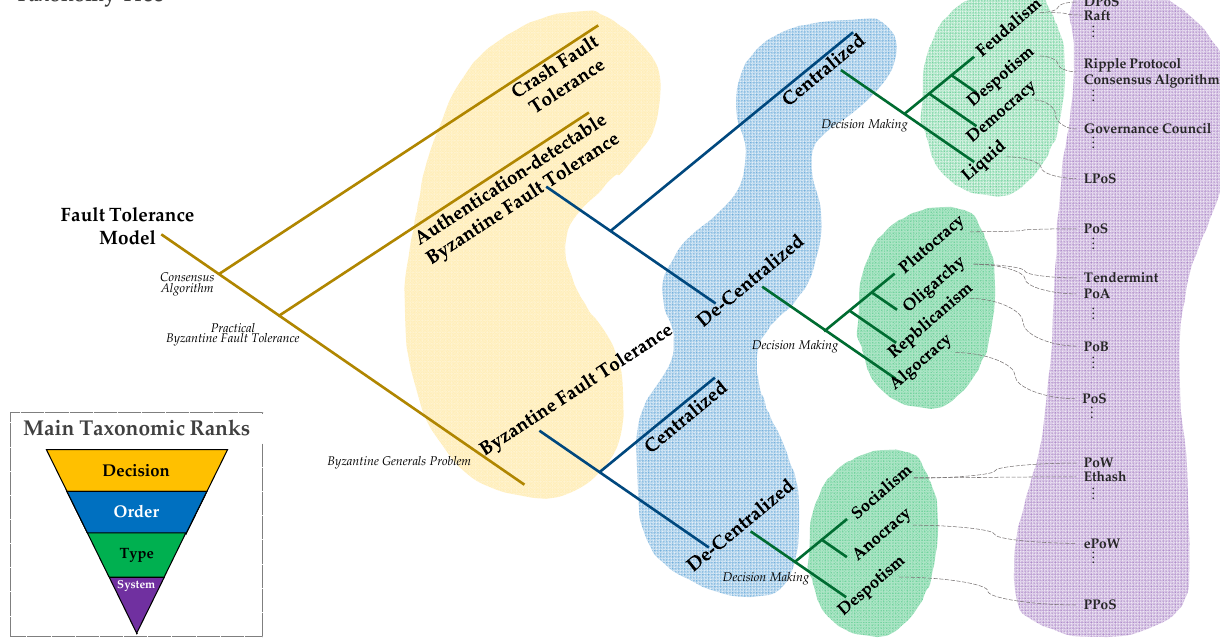
Figure 2. Blockchain taxonomy depicted as a hierarchical tree.